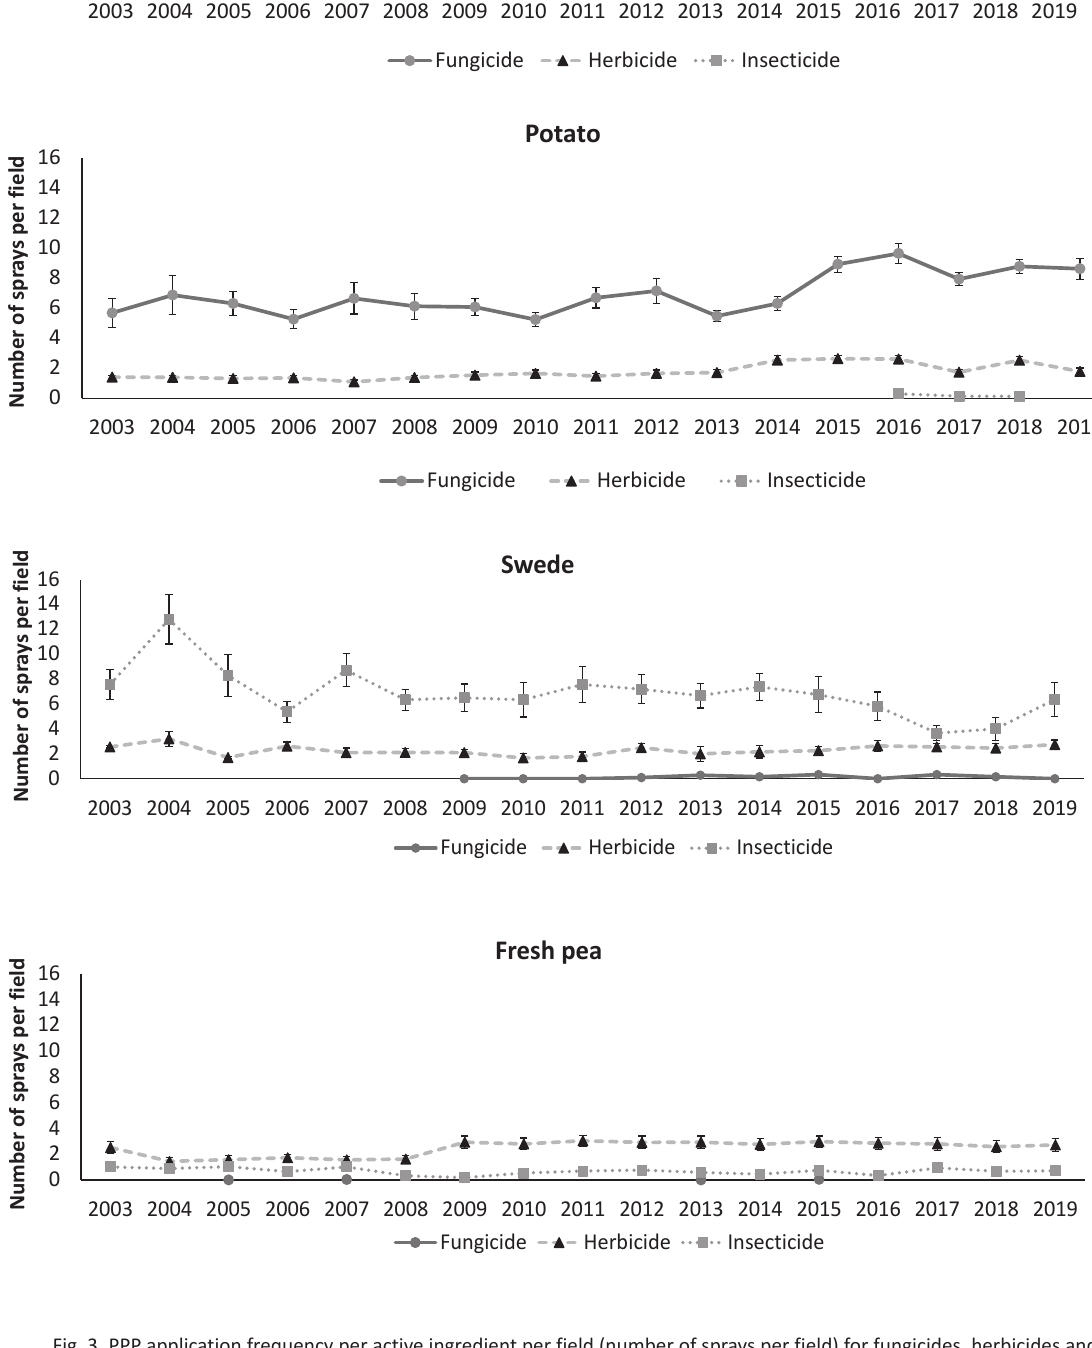
Figure 3D. Fig. 3. PPP application frequency per active ingredient per field (number of sprays per field) for fungicides, herbicides and insecticides on carrot (A), potato, (B) swede (C) and fresh pea (D) in 2003–2019